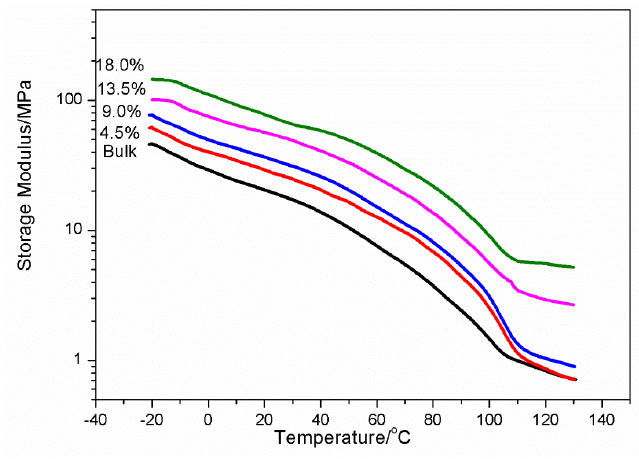
Figure 6. Storage modulus of the Fe 3 O 4 /SBS/LLDPE composites.